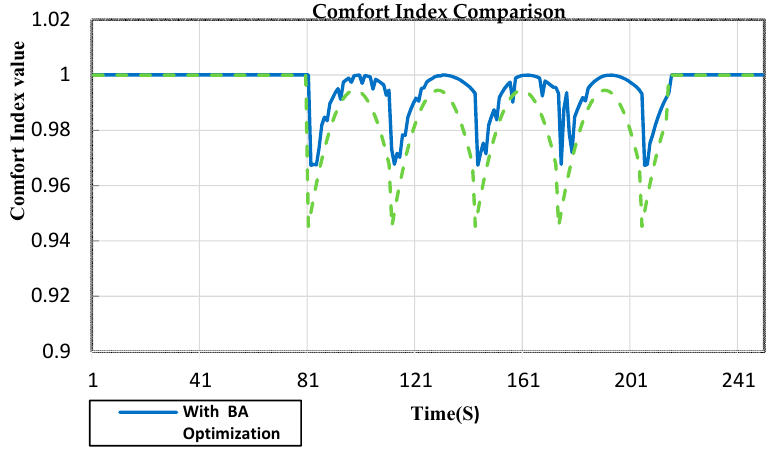
Figure 21. User comfort index values with and without BA optimization.